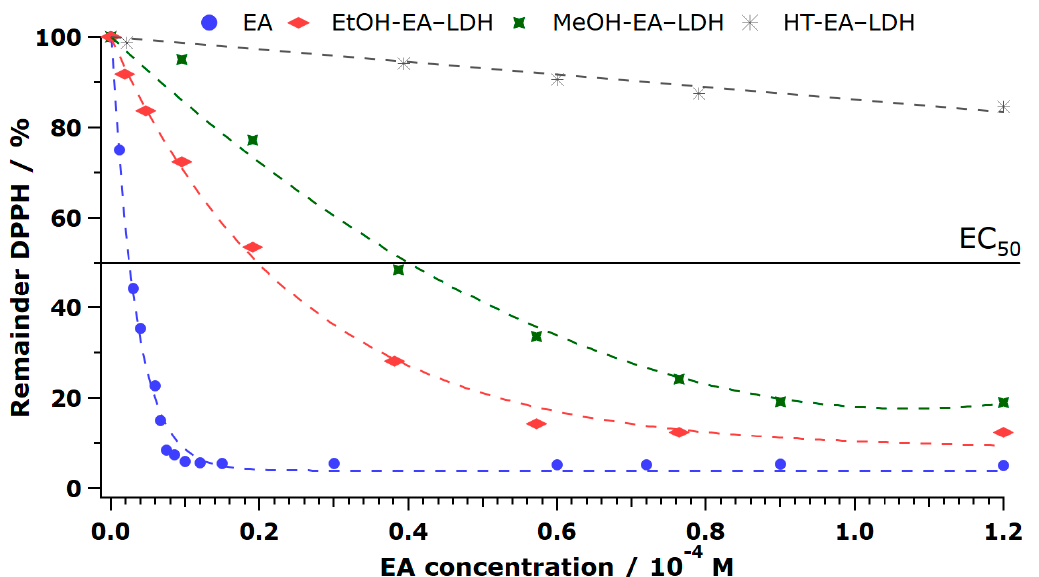
Figure 5. Changes in DPPH concentration in the presence of EA (dashed lines) and EA-LDH (full lines) as a function of the reaction time at 3 different initial antioxidant doses.